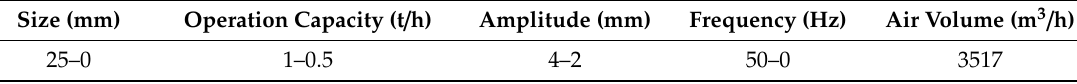
Table 1. Characteristics of testing system of fine compound dry separator.